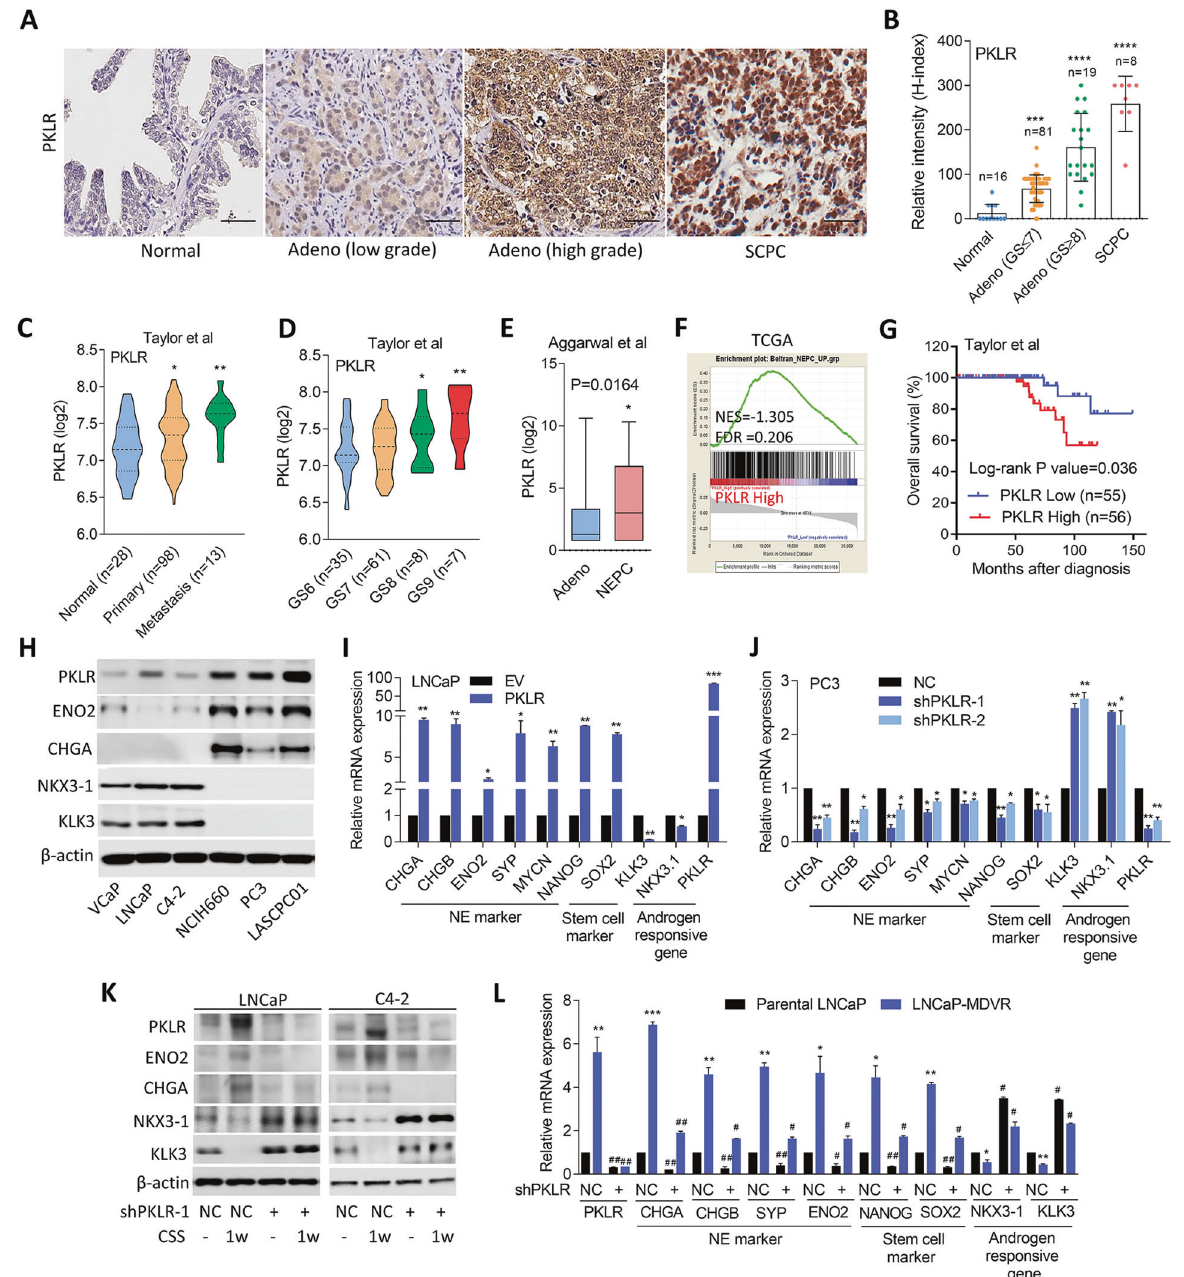
(Supplementary Fig. S3D). Moreover, tissues expressing high levels of ZBTB10 were negatively associated with upregulated neurode- velopment gene signatures and positively associated with upregulated AR signaling responses as analyzed by GSEAs in Fig. S3E). In summary, these results indicated that inhibition of AR signaling may induce downregulation of ZBTB10 which was correlated with upregulation of PKLR in PCa